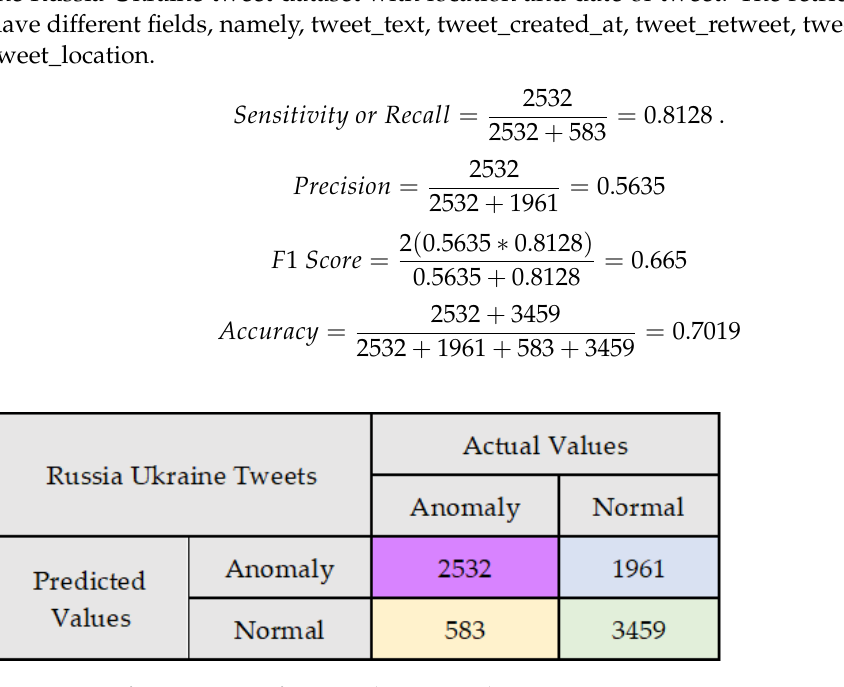
Figure 9. Confusion matrix of case study Russia Ukraine Tweet Dataset. Table 8. Sample tweets (Russia-Ukraine Tweet Dataset) with the corresponding location and date. Tweets Location Created